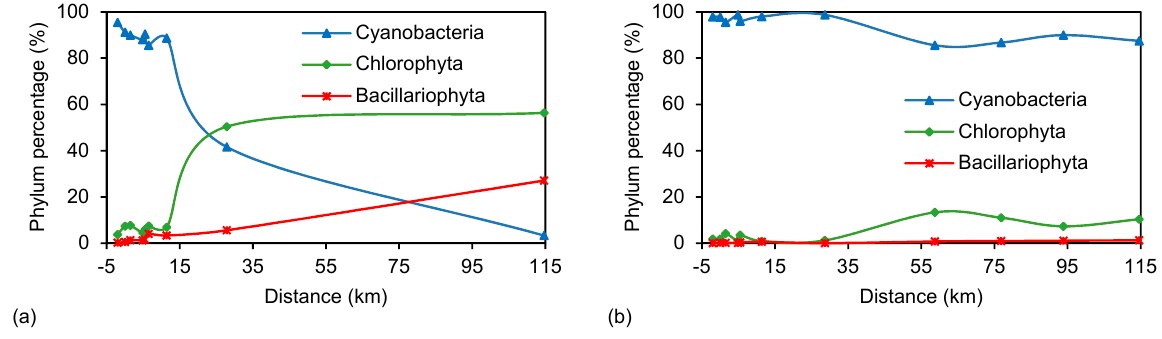
Figure 4. The trends of three main phytoplankton phyla in the Dianchi Lake-to-the Tanglang River ( a ) in June according to samplings at nine sampling stations ( b ) in September according to samplings at eleven sampling